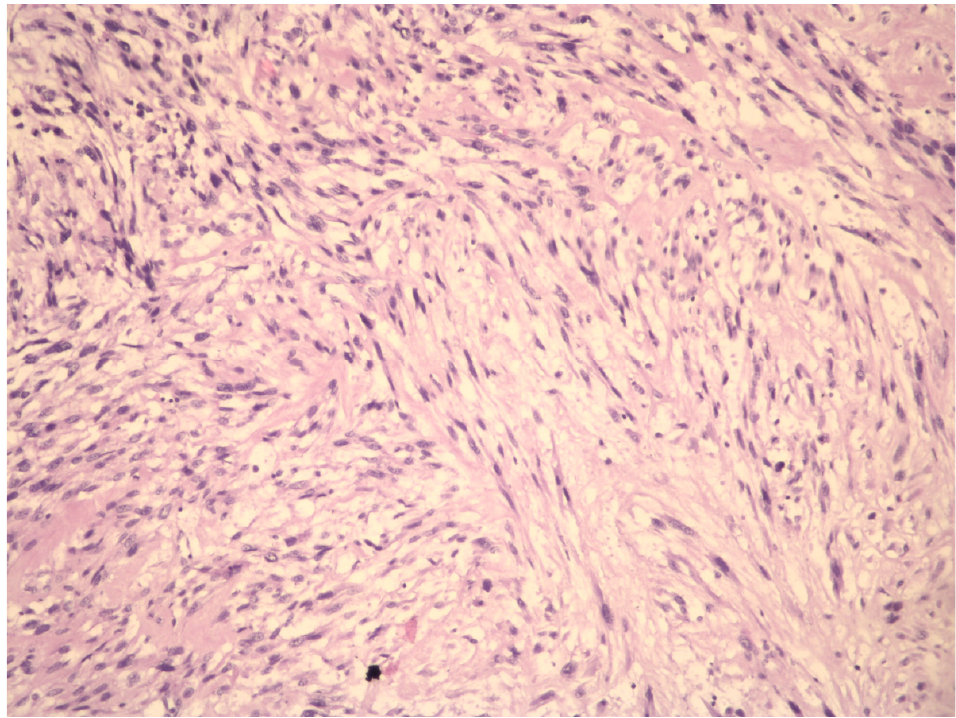
Figure 2. Aview of the pathohistological preparation of LMS cells (magnification at 10×). The cytologic atypic LMS cells have large, irregularly shaped and pleiomorphic nuclei with scarce chromatin.